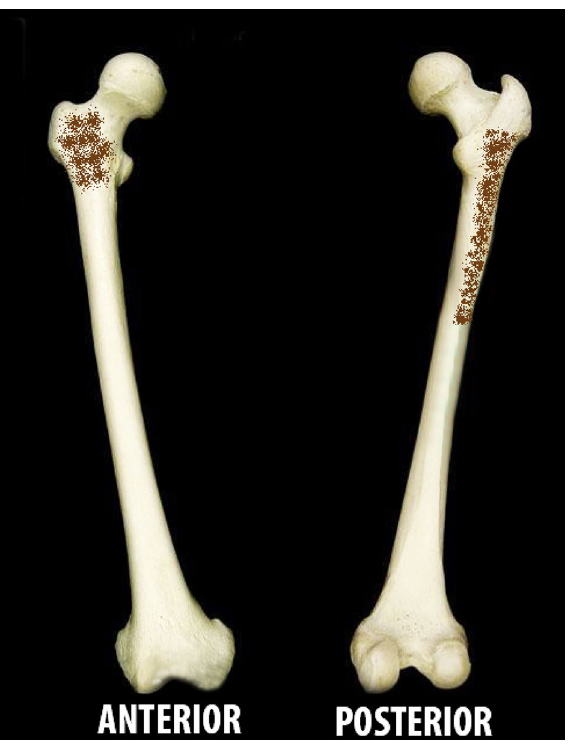
Figure 2. Schematic diagram showing the origin of additional muscle head of quadriceps